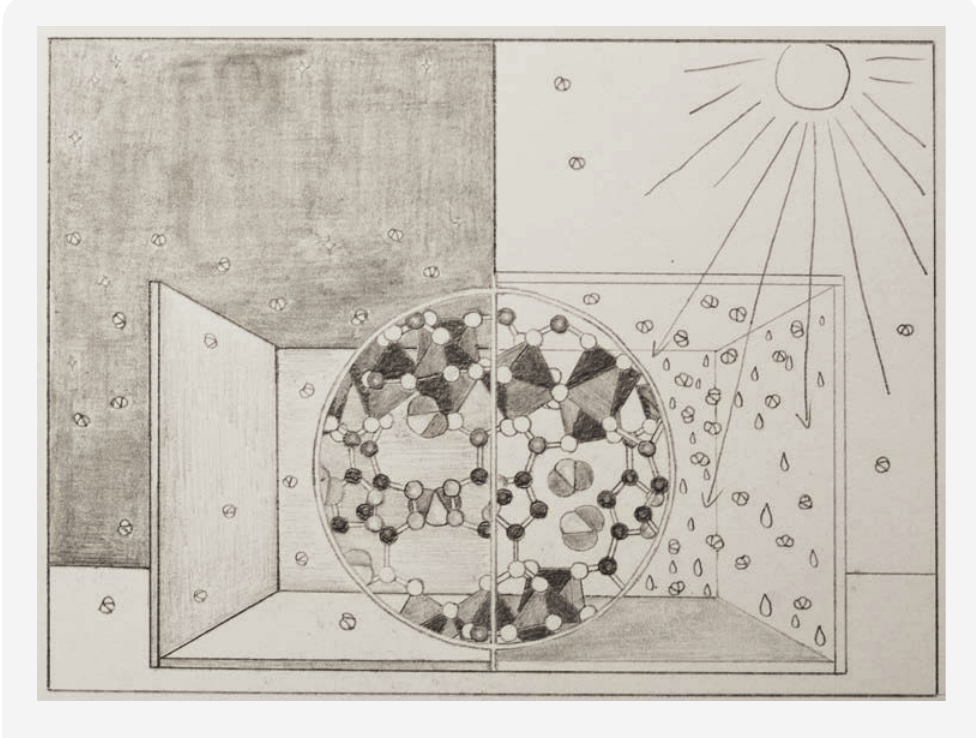
Fig. 6. MOF water harvesting device. Water enters the MOF at night (left side), and during the day sunlight heats the MOF resulting in release of water and its condensation